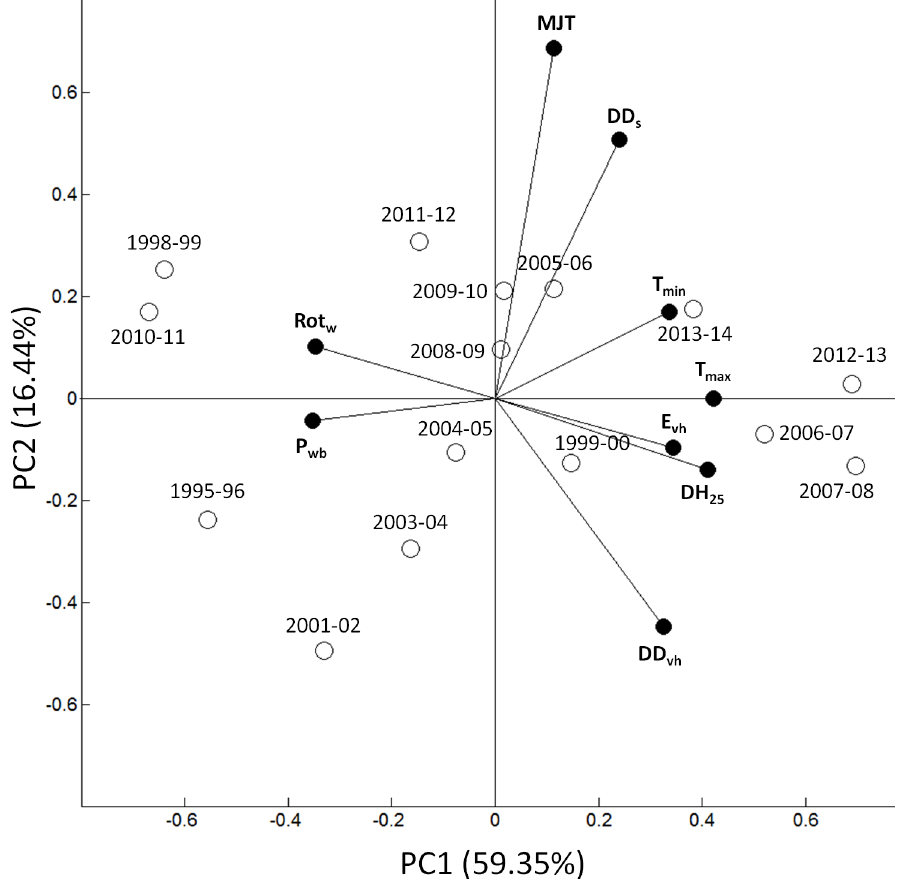
Fig 5. Principal component analysis biplot of the mean PC scores of each weather parameters as vectors, together with the PC scores of each season. PC1 and PC2 count for 59% and 16% of total variance, respectively. The abbreviations used in this figure are wine rotundone concentration (Rot w ), mean maximum temperature (T max ), mean minimum temperature (T min ), mean daily solar exposure (E vh ), percentage of degree hours > 25°C (DH 25 ), mean January temperature (MJT), vineyard water balance (P wb ), cumulative growing degree days from October to harvest (DD s ) and cumulative growing degree days from veraison to harvest (DD vh